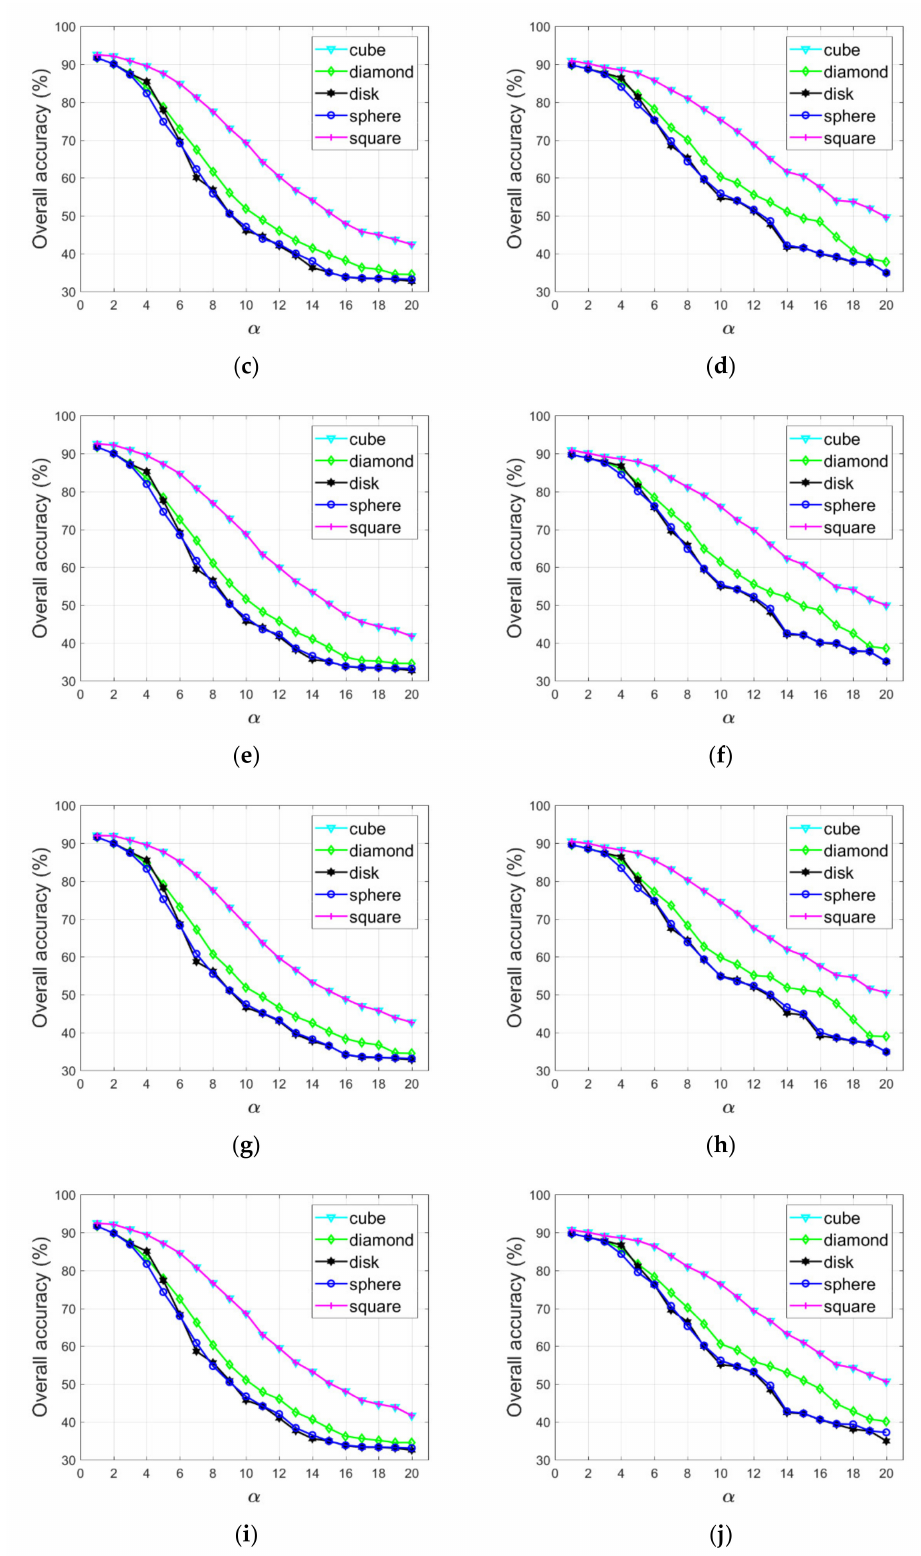
Figure 10. The sensitivity of the LSI algorithm to the morphological structuring element in variant color space for test images. ( a ) Tripoli-1 in HIS. ( b ) Tripoli-2 in HIS. ( c ) Tripoli-1 in HSV. ( d ) Tripoli-1 in HSV. ( e ) Tripoli-1 in CIELCh. ( f ) Tripoli-2 in CIELCh. ( g ) Tripoli-1 in YCbCr. ( h ) Tripoli-2 in YCbCr. ( i ) Tripoli-1 in YIQ. ( j ) Tripoli-2 in